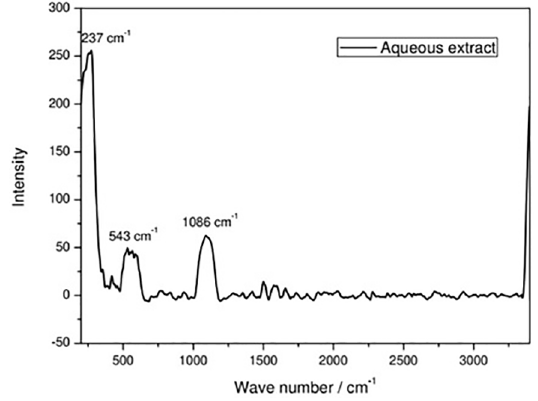
Figure 1. Raman spectra of the AEAW.